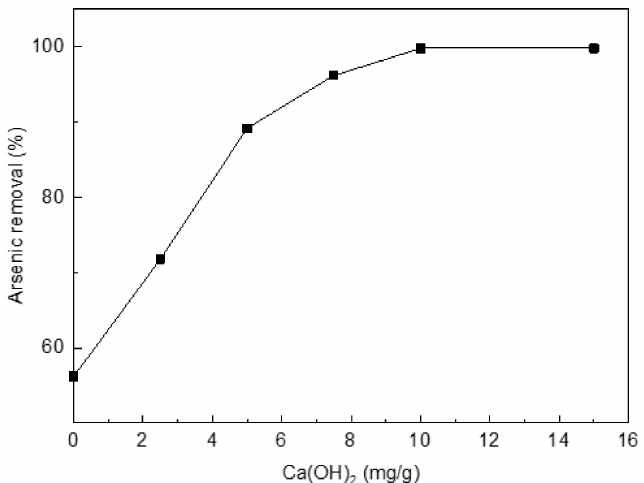
Figure 2. Effect of loading Ca(OH) 2 on arsenic(III) adsorption. Initial [As]: 10 mg/L; pH: 8.5; temperature: 25 ◦ C; equilibration time: 12 h.